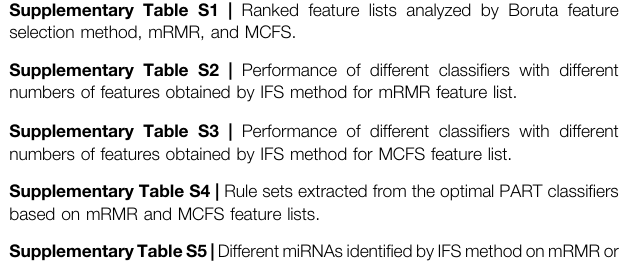
Supplementary Table S1 | Ranked feature lists analyzed by Boruta feature selection method, mRMR, and MCFS. Supplementary Table S2 | Performance of different classi fi ers with different numbers of features obtained by IFS method for mRMR feature list. Supplementary Table S3 | Performance of different classi fi ers with different numbers of features obtained by IFS method for MCFS feature list. Supplementary Table S4 | Rule sets extracted from the optimal PART classi fi ers based on mRMR and MCFS feature